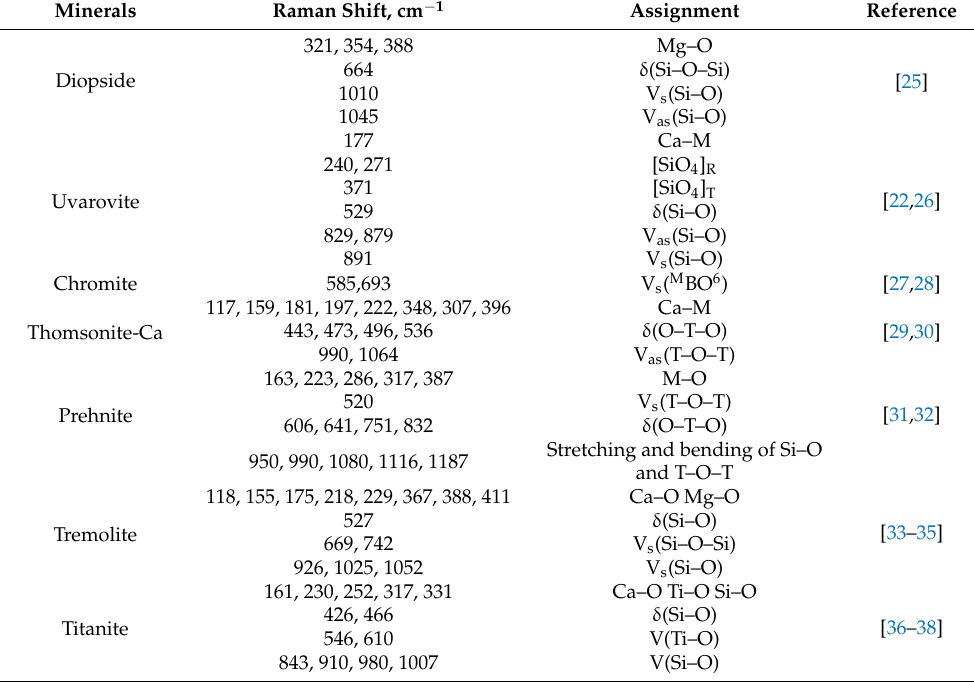
Table 6. The assignments of the different minerals (after Raman microprobe measurement).